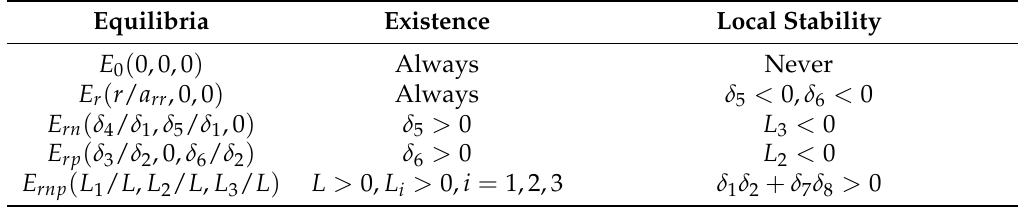
Table 1. Existence and local stability of equilibria for model